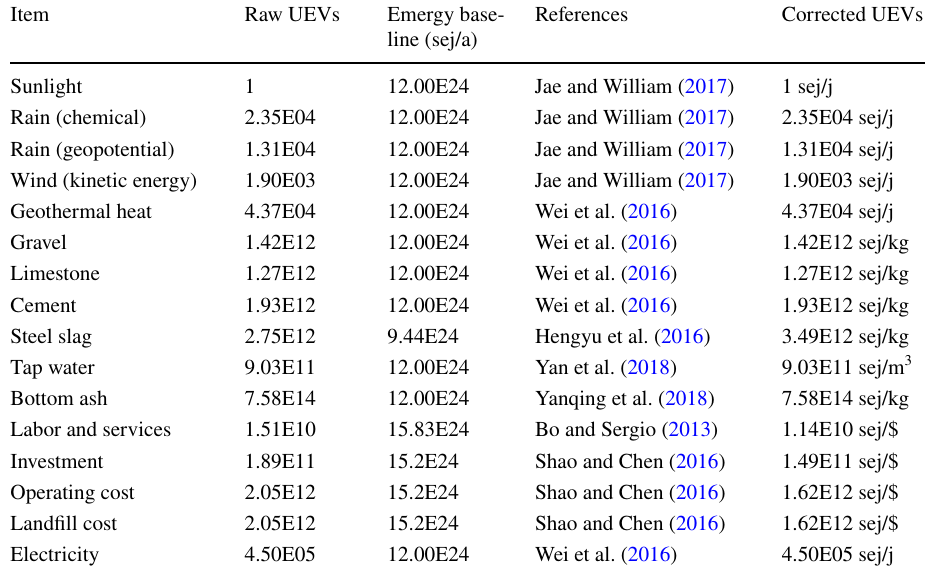
Table 4 Unit emergy values (UEVs) correction based on 12.00E24 sej/year (Mark et